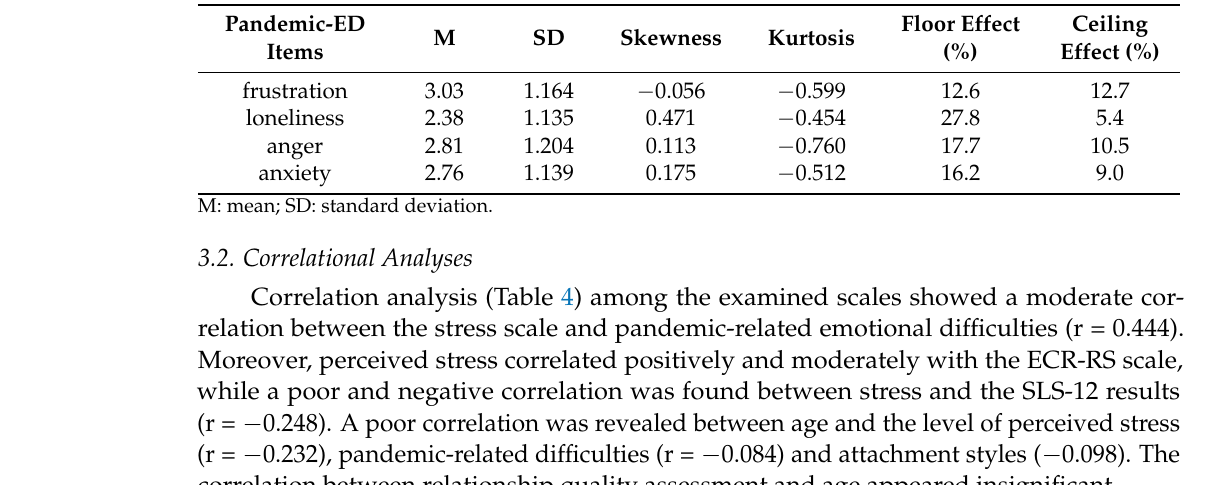
Table 3. Descriptive statistics, floor and ceiling effects for individual items (N = 1405).